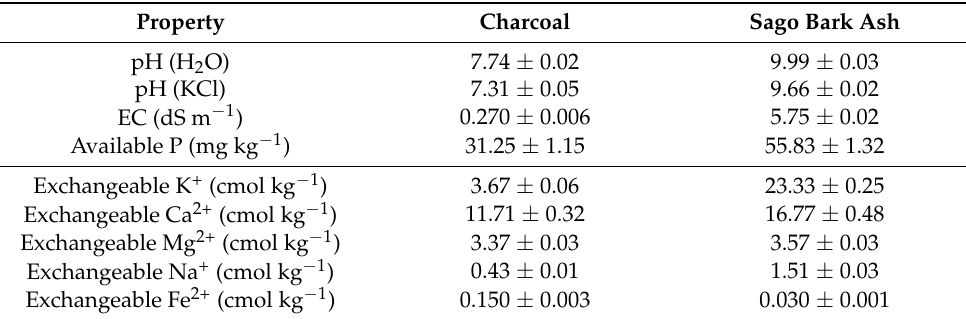
Table 2. Selected chemical properties of charcoal and sago bark